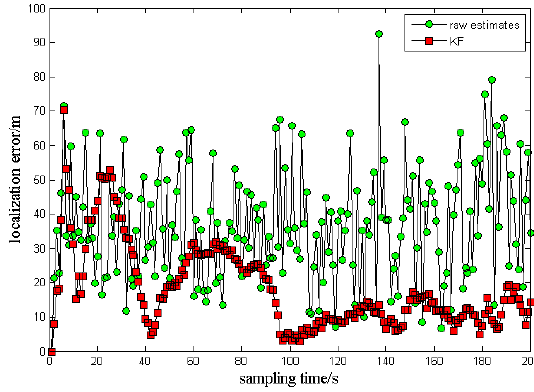
Figure 11. Localization errors after modified adaptive Kalman filtering.